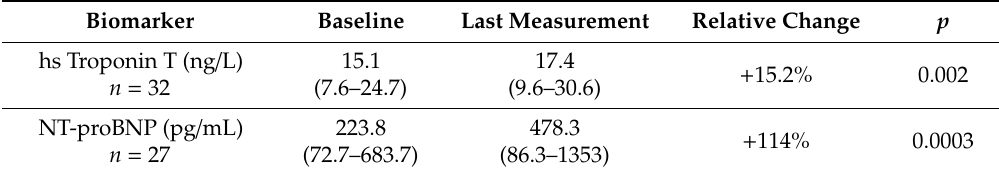
Table 3. Change in circulating biomarkers’ levels between baseline and last measurement.